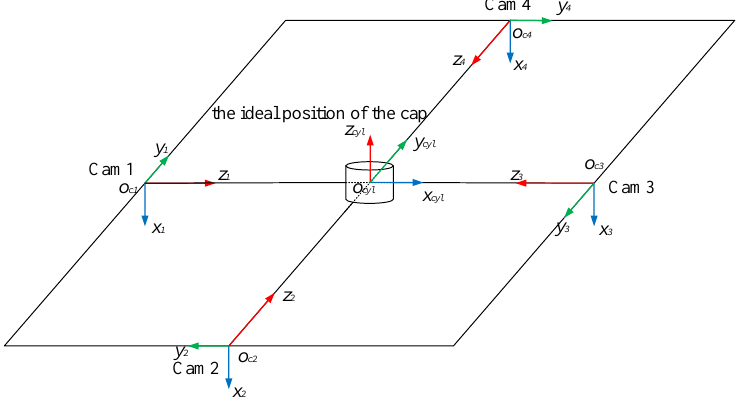
Figure 5. The ideal position and pose of the bottle cap.